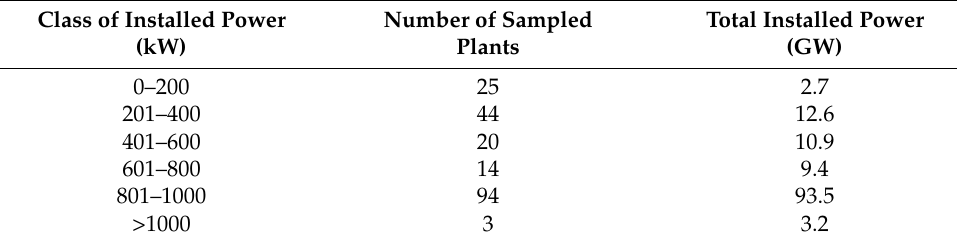
Table 3. Frequency of sampled digesters split by power capacity.